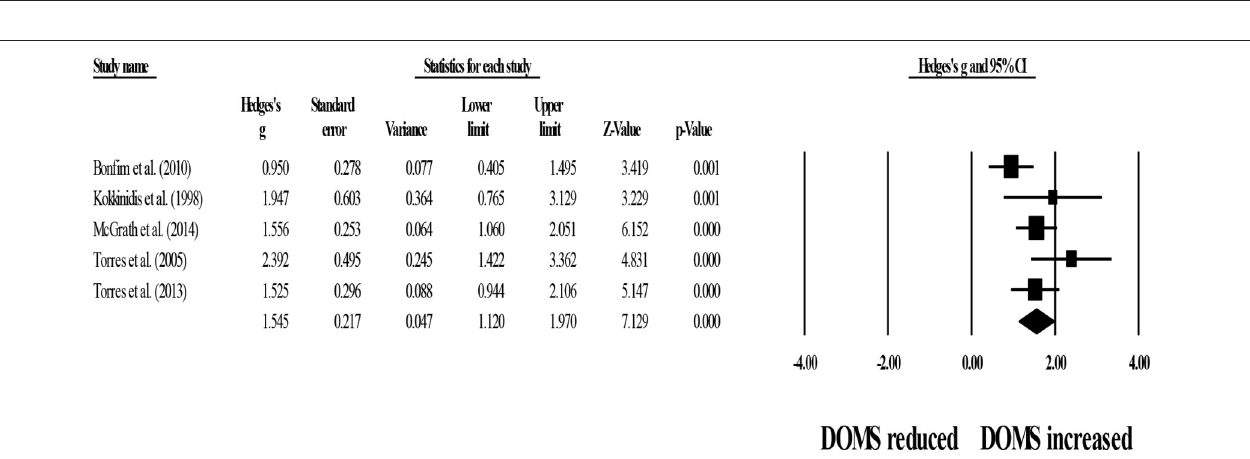
FIGURE 5 | Forest plot of changes in short-term strength recovery after participating in post-exercise stretching protocols compared to control conditions (i.e., passive recovery). Values shown are effect sizes (Hedges’s g) with 95% confidence intervals (CI). The size of the plotted squares reflects the statistical weight of each study. The black diamond reflects the overall result.